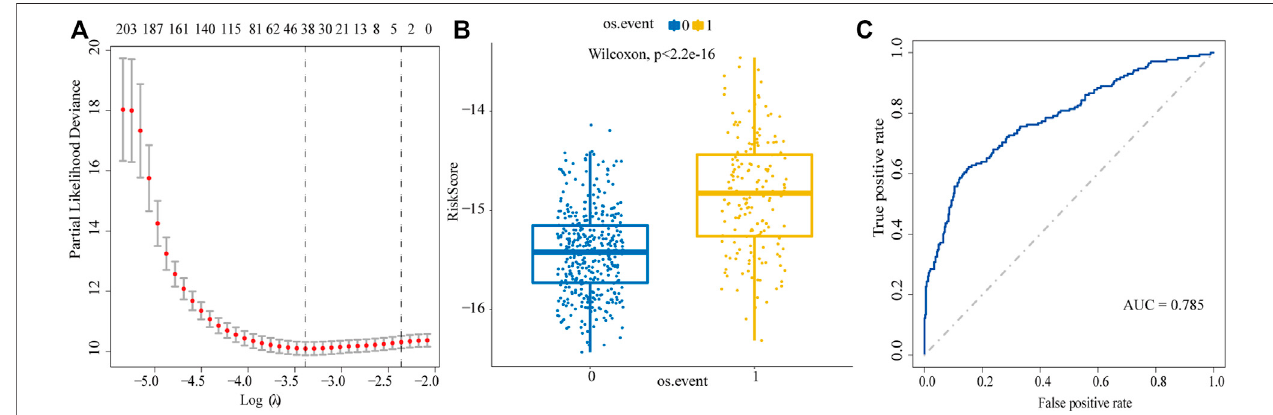
FIGURE2| Screenprognostic genesbyLassoregressionanalysis. (A) AcquisitionofthebestLambdavalue. Theleftdashed linerepresentslambda.min,theright dashed line represents lambda.1se. (B) To distinguish the survival and death events by the model based on lambda.min. 0: alive, 1: death. (C) ROC curve is used to evaluate the predictive performance of the model.